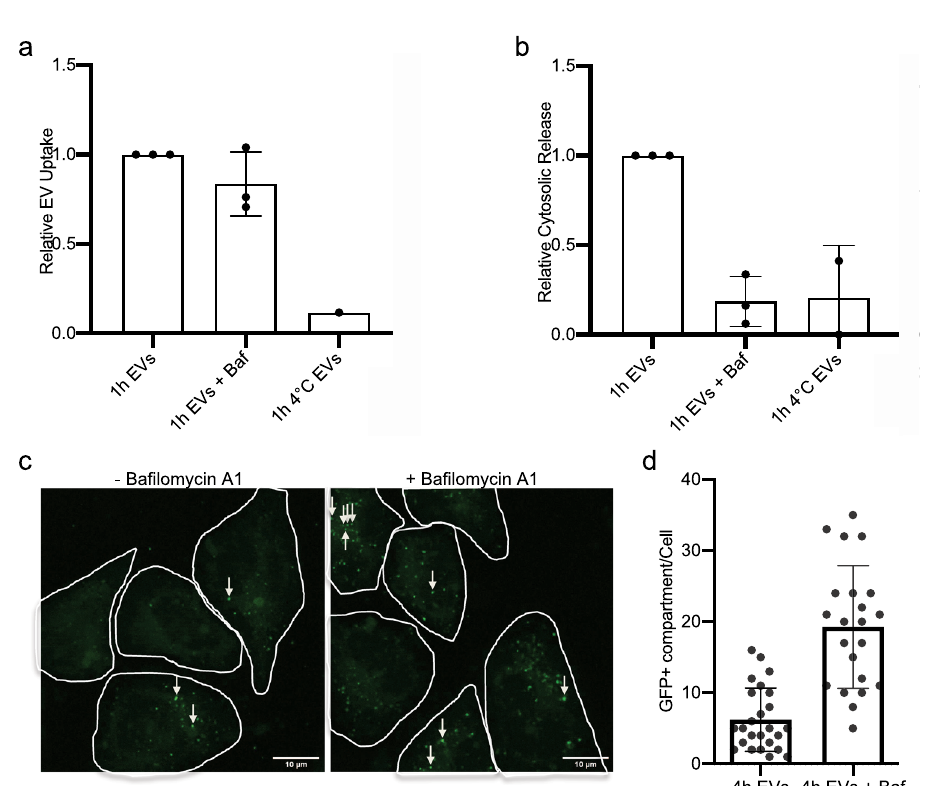
Fig. 4 Endo/lysosomal acidi fi cation is required for EV-content delivery. a Quanti fi cation of NLuc-Hsp70 EV uptake by unlabeled acceptor HeLa WT cells, with or without Ba fi lomycin A1 (Baf) treatment. Cells were incubated at 4 °C as negative control (no EV uptake). The EV uptake in control condition (non- treated) was set to 1. Each dot is an independent replicate and represents the means of 2 or 3 technical replicates, from left to right n = 3, 3, 1. Error bars represent standard deviations. b Quanti fi cation of NLuc-Hsp70 EV-content delivery within unlabeled acceptor HeLa WT cells, with or without Ba fi lomycin A1 (Baf) treatment. Cells were incubated at 4 °C as negative control (no EV-content release). The cytosolic release from the control condition (non- treated) was set to 1. Baf treatment (loss of endosomal acidi fi cation) inhibits the content release. Each dot is an independent replicate and represents the mean of 2 or 3 technical replicates, from left to right n = 3, 3, 2. Error bars represent standard deviations. c Confocal micrographs of HeLa acceptor cells after 4 h incubation with GFP-Hsp70 EVs with or without Baf treatment. White arrows indicate GFP-positive dots. Micrographs representative of three independent experiments. d Quanti fi cation of the number of GFP-positive dots per cell on unlabeled acceptor HeLa WT cells after 4 h incubation with GFP- Hsp70 EVs with or without Baf treatment. Each dot represents the value of GFP foci number within one acceptor cell, from left to right n = 25, 22. Error bars represent standard